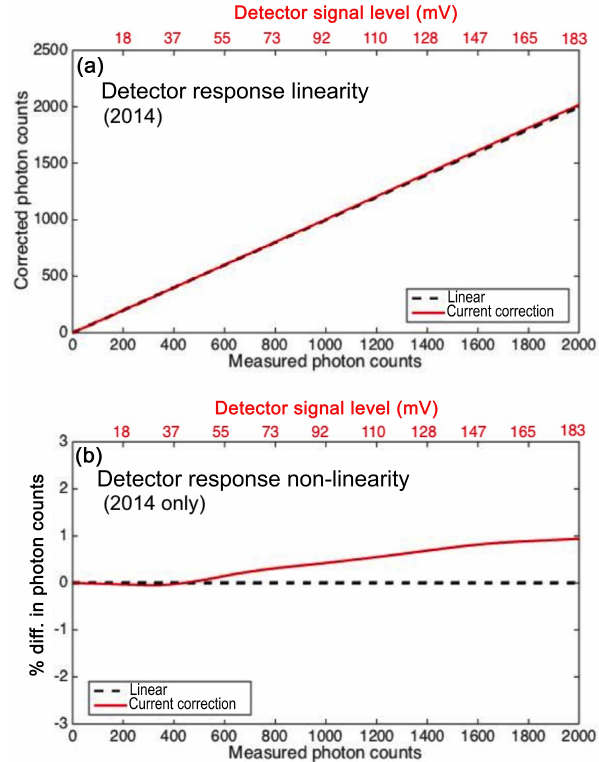
Figure 7. The results from calibrating the linearity of the lidar’s HgCdTe detector for the 2014 lidar configuration. (a) Measurement of the detector output vs. optical input. (b) Deviation from linear re- sponse in the detector response, showing a deviation starting at 600 photons with a maximum deviation of 1%. For the 2016 flights, the receiver optics were improved so that the optical signal was more uniformly distributed across the detector array elements, and an ad- ditional electronic preamplifier stage was used. Together these re- duced the nonlinearity effect so that its effect was negligible for the 2016